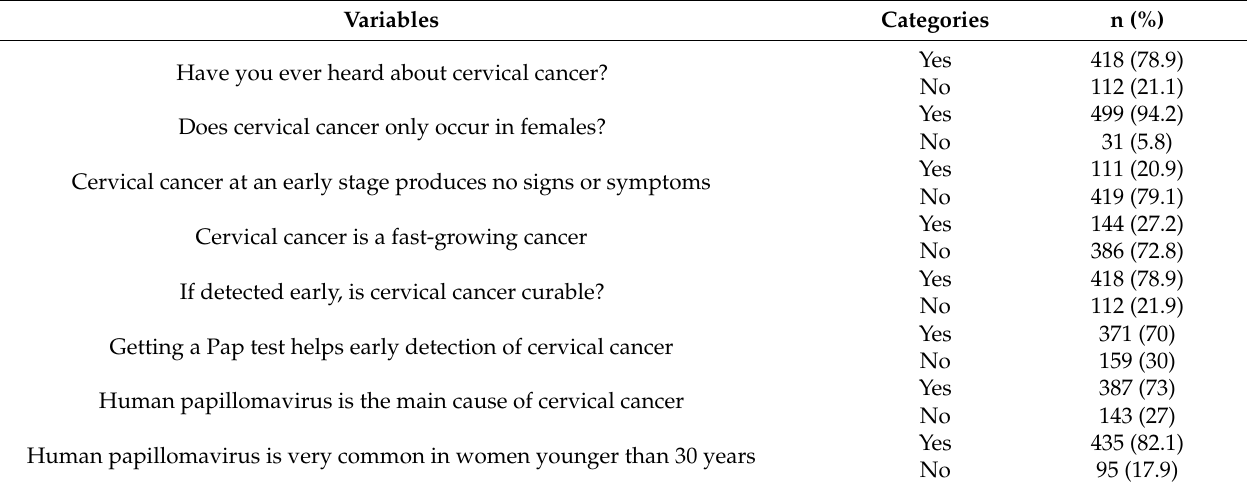
Figure 1. Knowledge-related questionnaire of the respondents on awareness, acceptance, and associ- ated factors of human papillomavirus vaccine among parents of daughters in Hadiya zone, southern Ethiopia, 2021 (n = 530).